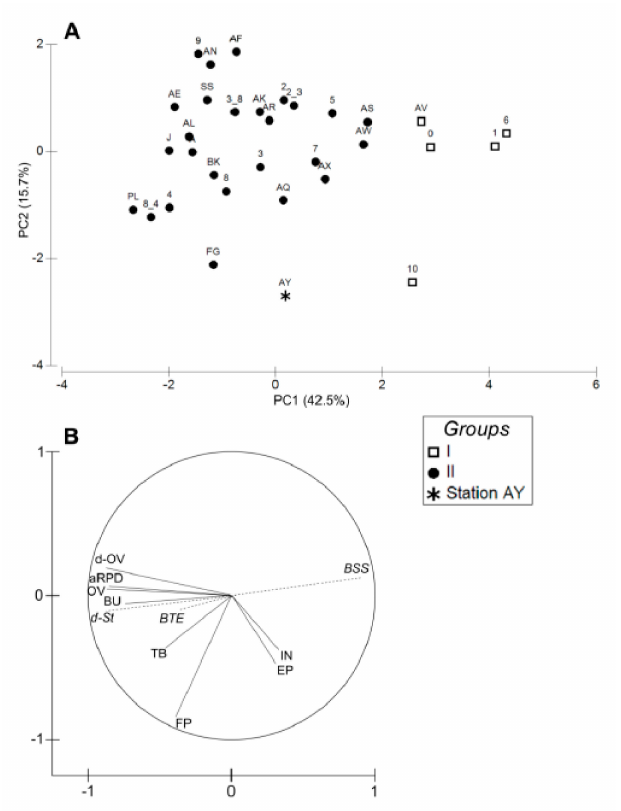
Figure 8. Principal component analysis based on normalized mean SPI characteristics (aRPD: aRPD thickness; BU: number of burrows; OV and d-OV: number and maximal depth of oxic voids; FP: number of feeding pits; TB: tubes; EP: epifauna and IN: infauna). Projection of stations on the first plane of the PCA ( A ), and correlations of the variables with its first two components ( B ). Station depth (d-St), Bottom Shear Stress (BSS), and Bottom Trawling Effort (BTE) were used as supplementary variables. Group identification was achieved through the coupling of hierarchical clustering with a SIMPROF procedure. Station codes are the same as in Figure 1 and Table